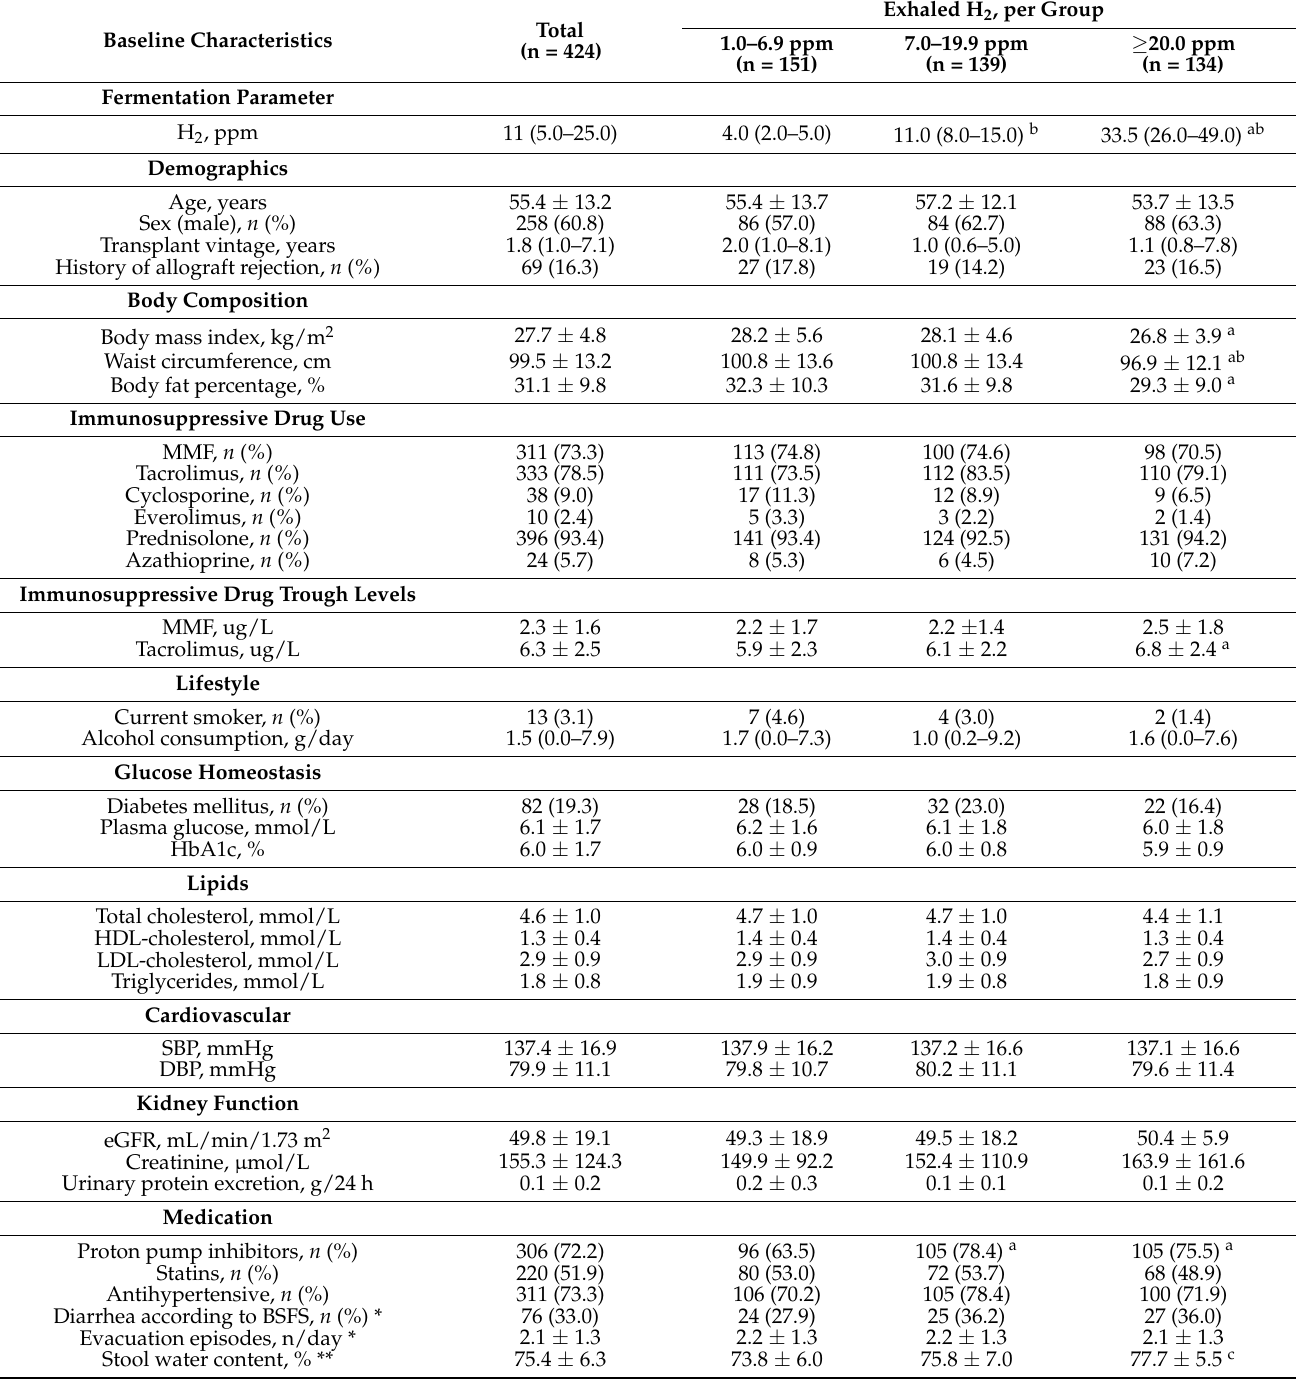
Table 1. Baseline characteristics of KTR according to groups of exhaled H 2